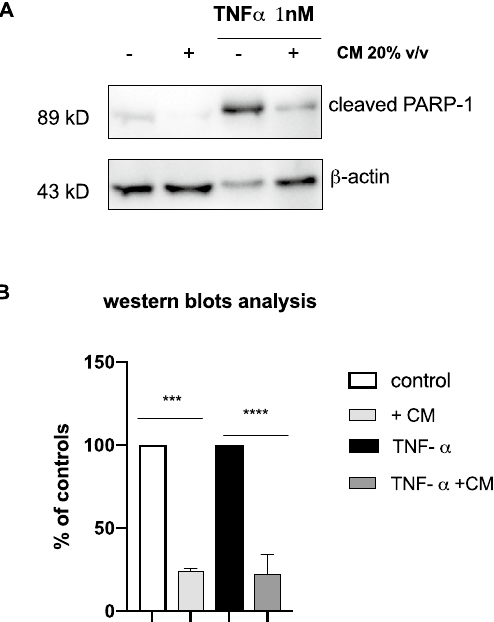
Figure 2. The conditioned Medium of L. gasseri SF1183 reduces apoptosis of HCT116 cells. ( A ) HCT116 cells were incubated or not with CM for 16 h where indicated; after that, cells were incubated with TNF-α 1 nM for additional 8 h where indicated. Cells were collected and extracts were analyzed by western blot with antibodies against cleaved PARP-1 and β-actin. ( B ) Quantification of normalized cleaved PARP-1 levels from three independent replicates performed by ImageLab. Statistical analyses were performed by unpaired t-test. Levels of significance are indicated (***p = 0.0002, **** p <